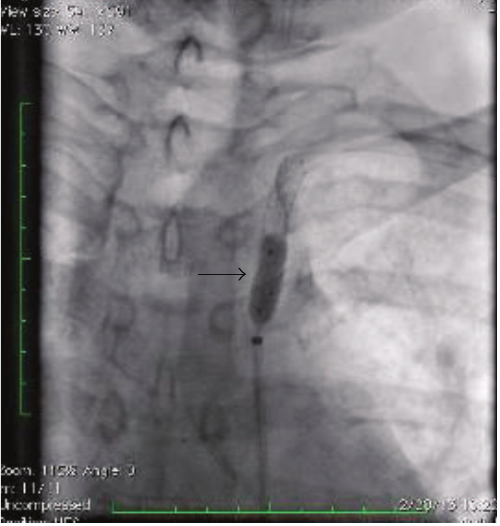
Figure 4: Angiogram showing balloon